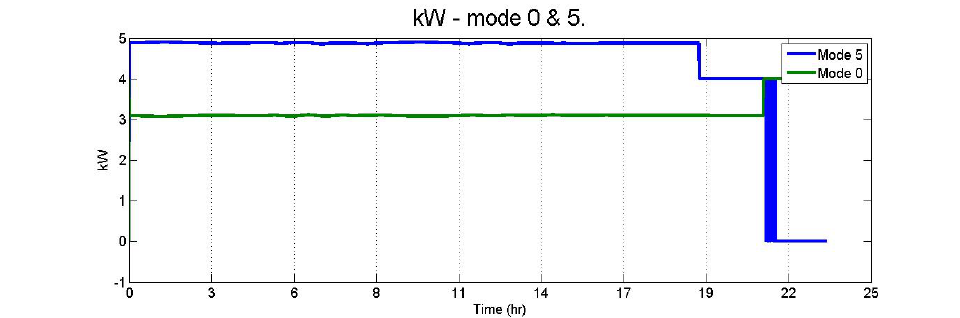
Figure 20. Cooling capacity for Modes 0 and 5.